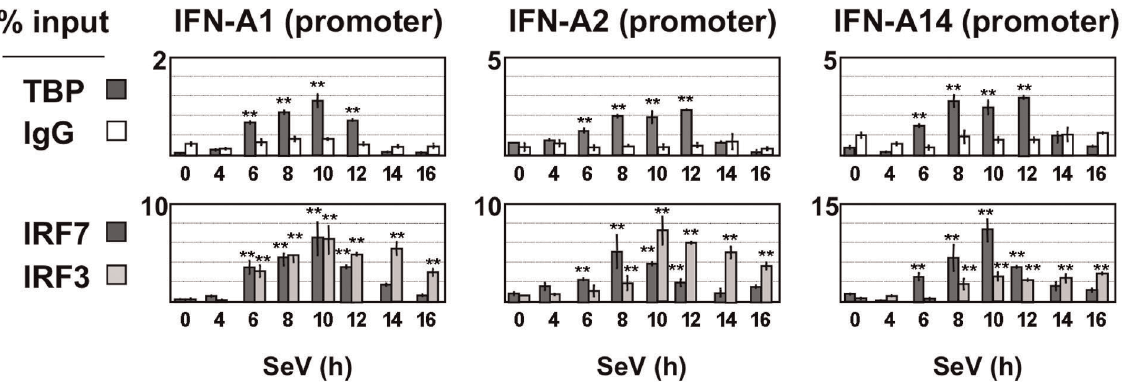
Figure 2. Recruitment of IRF3, IRF7 and TBP to IFN-A gene promoters. Recruitment to the IFN-A2, A14 and A1 gene promoters was determined by ChIP-QPCR assays in Namalwa B cells infected by Sendai virus. Cross-linked chromatin extracts were immunoprecipitated with antibodies specific for TBP, IRF7 or IRF3 and submitted to QPCR analysis after reversion of cross-linking, as described in Materials and Methods. Anti- rabbit IgG was used to determine background levels of non-specific binding. Data are expressed as % of the DNA input. Values are mean and standard deviation for two replicate samples derive from two representative experiments (n=4). The error bars indicate the relative standard